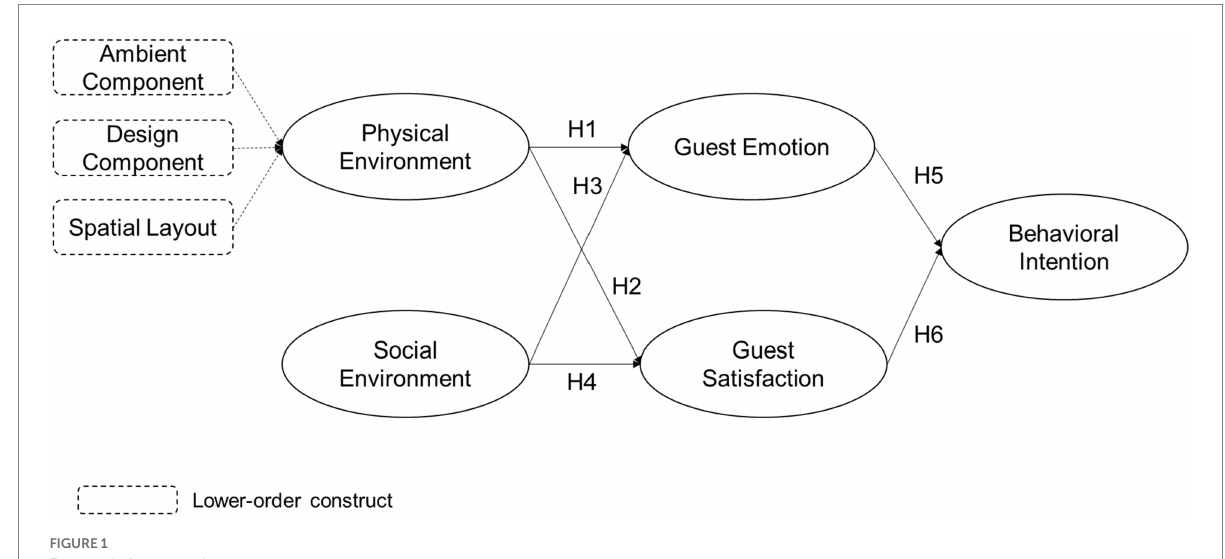
FIGURE 1 Research